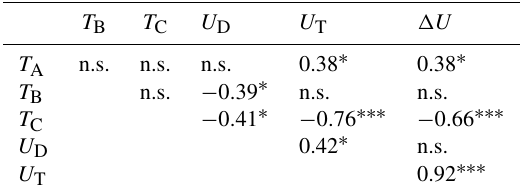
were not significantly correlated with one another (Table 2).